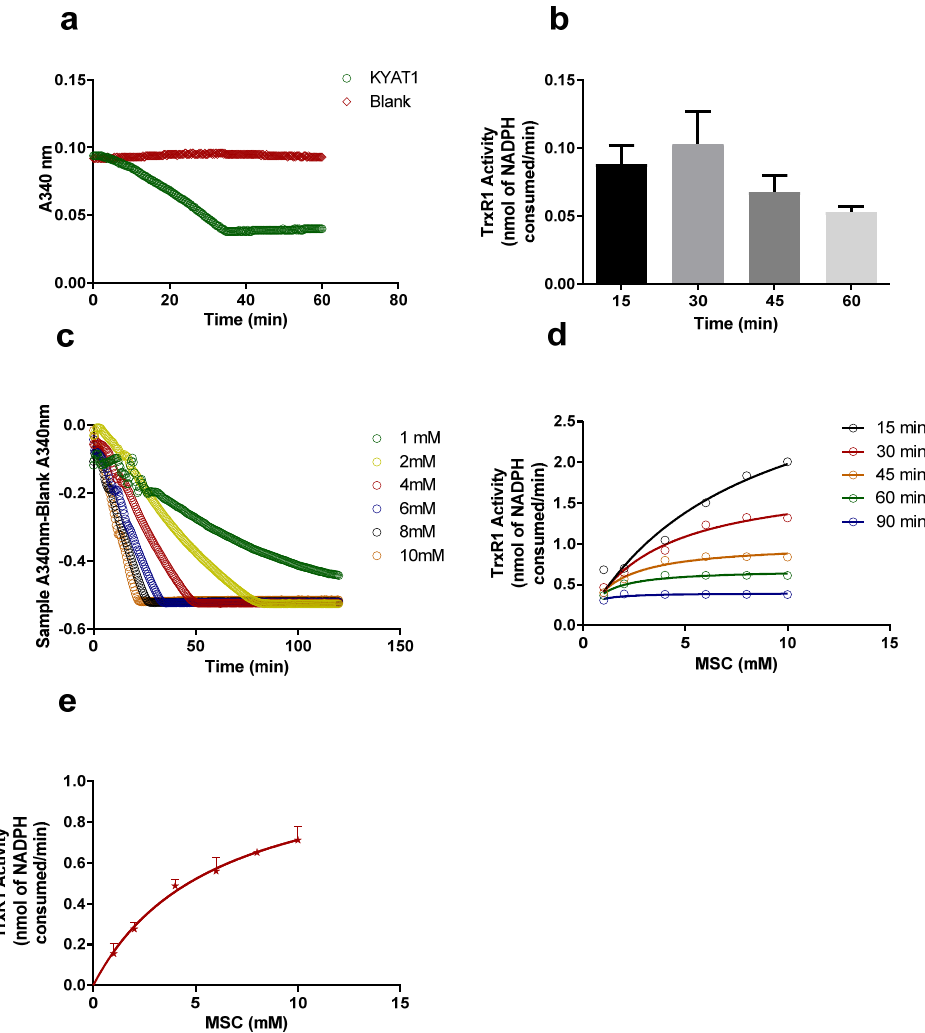
Figure 2. Kynurenine aminotransferase 1 (KYAT1) and thioredoxin reductase 1 (TrxR1) coupled activity assay to detect methylselenol generation. ( a ) TrxR1 activity in the coupled activity assay mixture. The assay mixture contains 5 mM Se-methylselenocysteine (MSC) as a primary substrate and 100 ng of KYAT1 as a primary enzyme to metabolize MSC into methylselenol. Methylselenol was